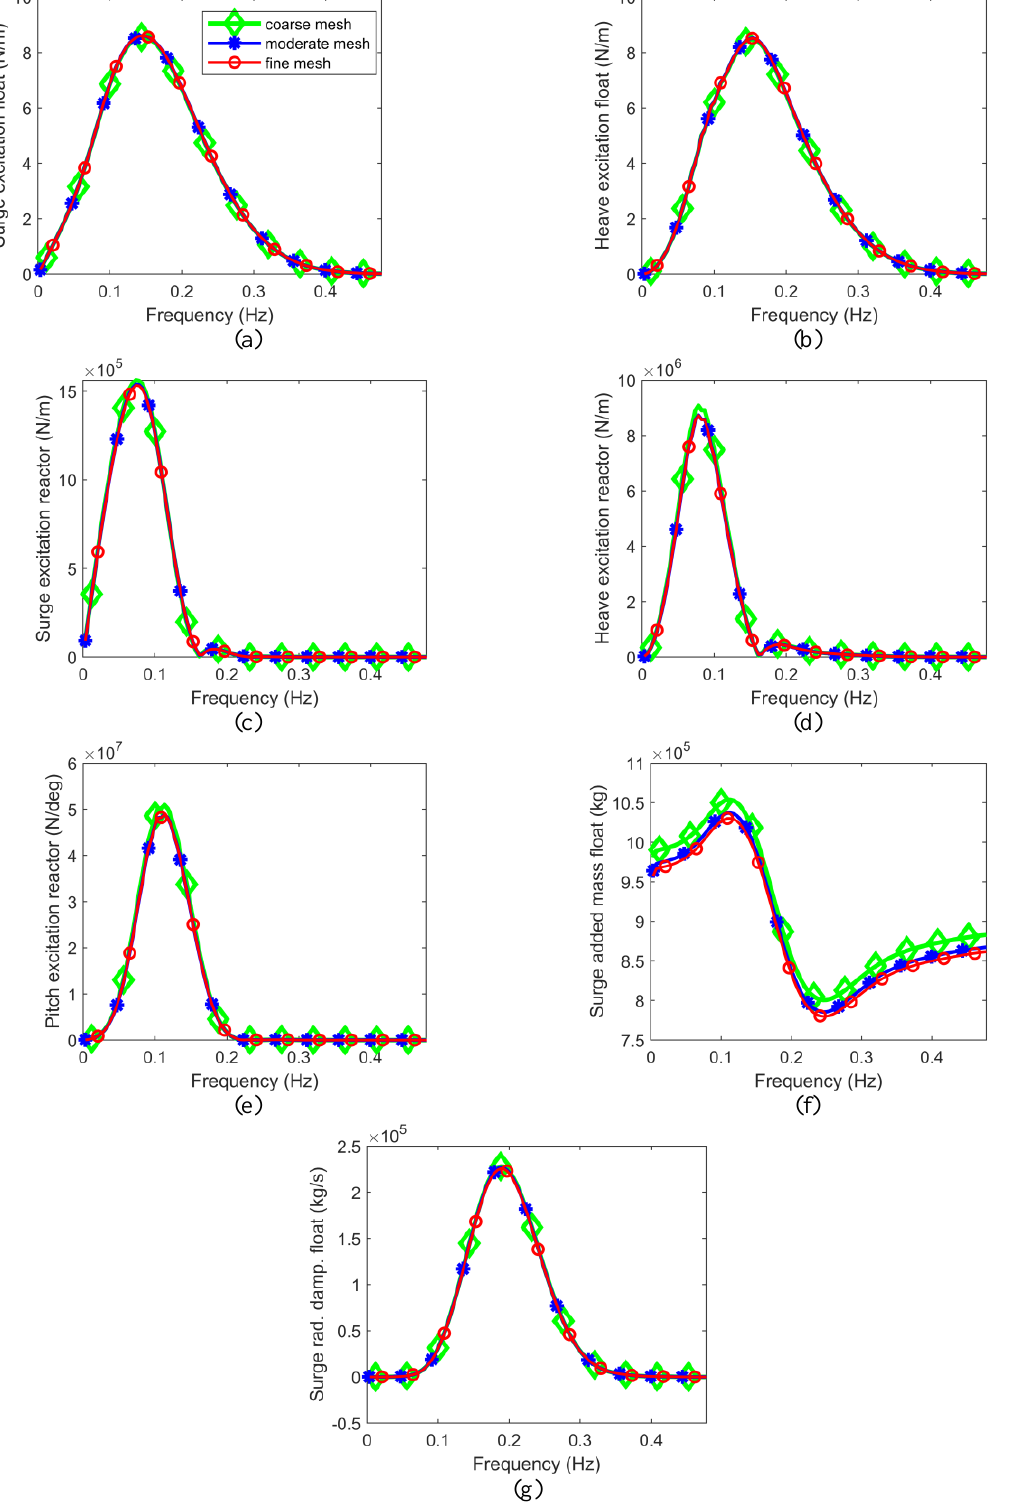
Fig. A.1: Surge, heave excitation coefficients of float (a,b), surge, heave and pitch of reactor (c,d, e), surge added mass coefficient and radiation damping of float